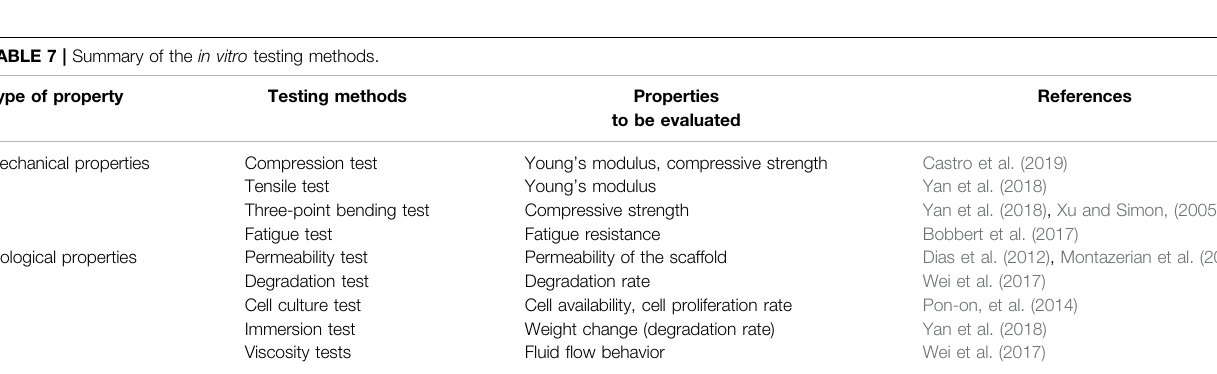
FIGURE6| Theanalysisprocedureforobtainingthepropertiesofporousscaffoldsusingthe fi niteelementmethod(adaptedfromLuetal.,2020a;Luetal.,2020b).